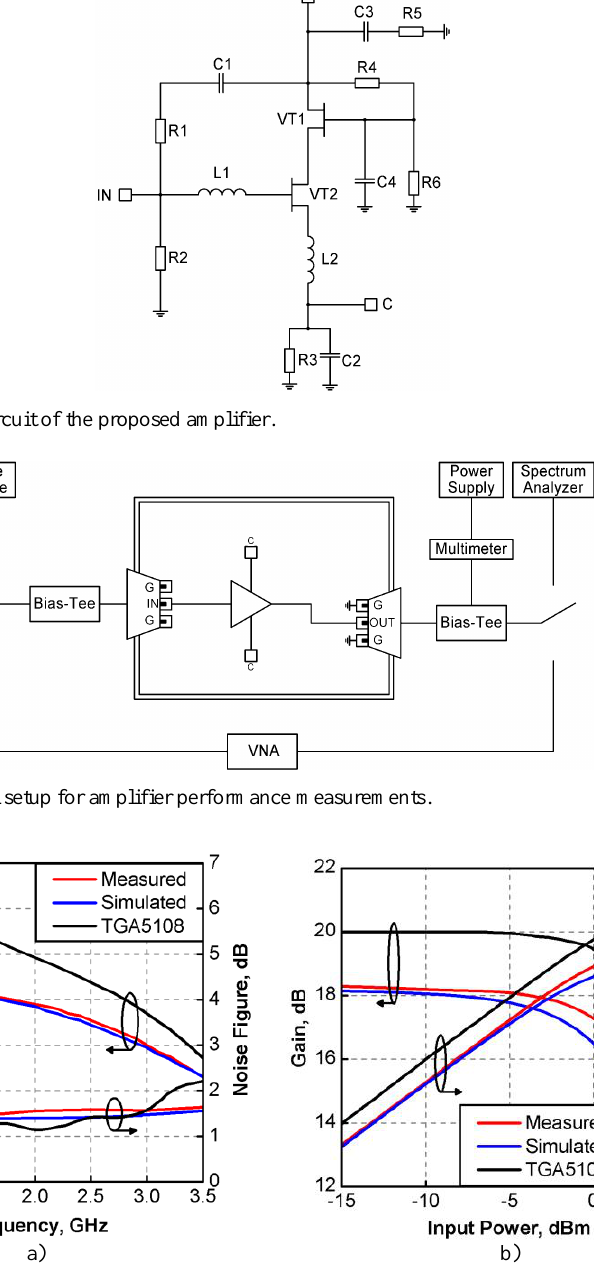
Fig. 3. Frequency dependence of the gain and noise figure (а) and gain and output power versus input power (b) for the proposed amplifier and